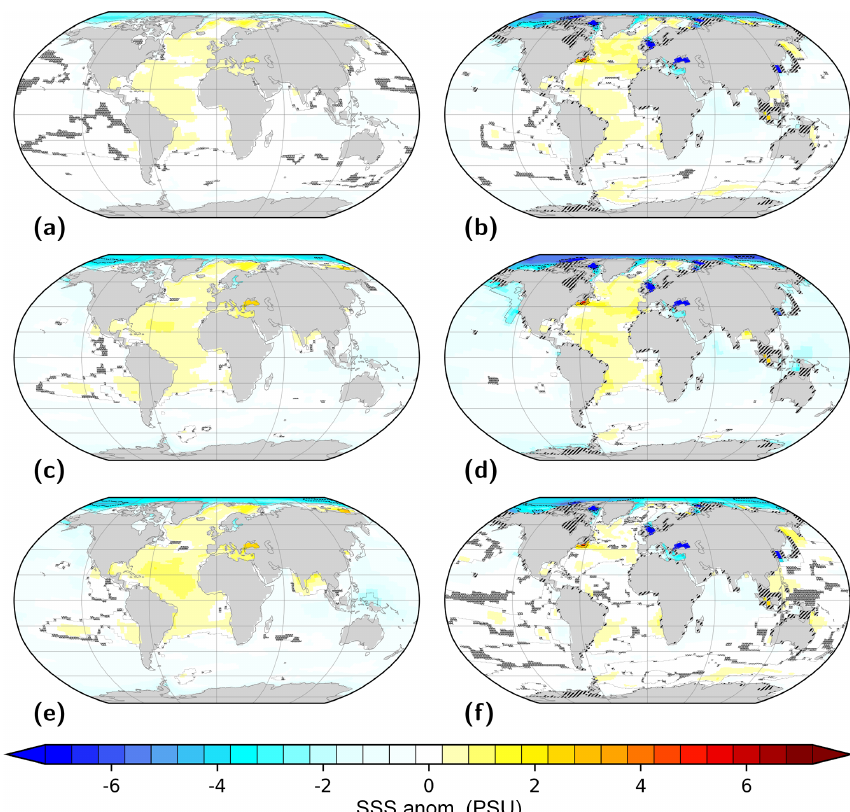
Figure 22. Annual mean anomaly of sea surface salinity (SSS) in PSU with respect to pre-industrial (PI, E280). We show the impact of comparable radiative forcing in setups with both modern (a, c, e) and mid-Pliocene (b, d, f) geography: (a) E400, (b) Eoi400, (c) E560, (d) Eoi560. We also show the impact of a further increased concentration of CO 2 , (e) E600, and PI CO 2 in a model setup with mid-Pliocene geography, (f) Eoi280. Light grey shading illustrates land–sea masks. In hatched ocean regions the anomaly is insignificant at the 95% confidence interval based on a t test. Hatches over land indicate differences in land–sea configuration between a specific simulation and the PI reference. Contours illustrate isolines of − 6 (dashed, thick), − 4 (dashed), − 2 (dashed, thin), 0 (dotted, thin), 2 (solid, thin), and 4PSU (solid). We define SSS as the salinity of the uppermost ocean layer centred around a depth of